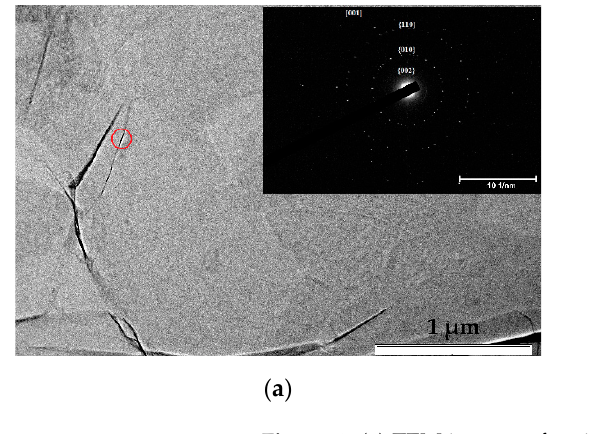
Figure 4. ( a ) TEM images of an initial unirradiated MLG. On the inset the diffraction pattern of a folded region was highlighted by the red circle; ( b ) High Resolution TEM images of the edge of a folded region. The inset shows enlarged image of a folded region indicating distance between graphene sheets of 0.348 nm.